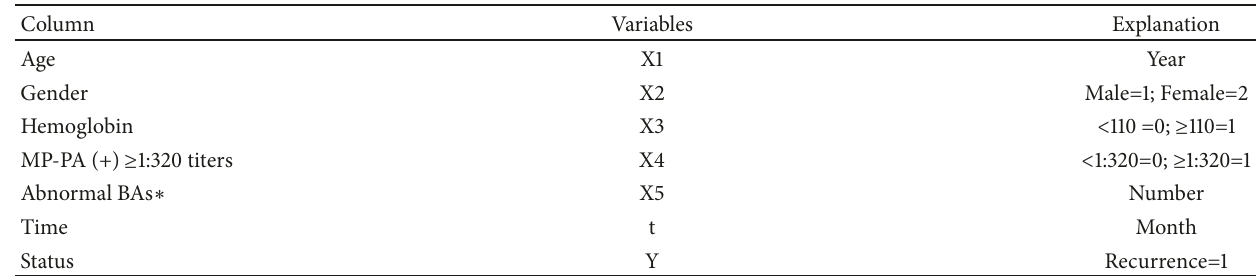
(a) Variables in Cox regression analysis